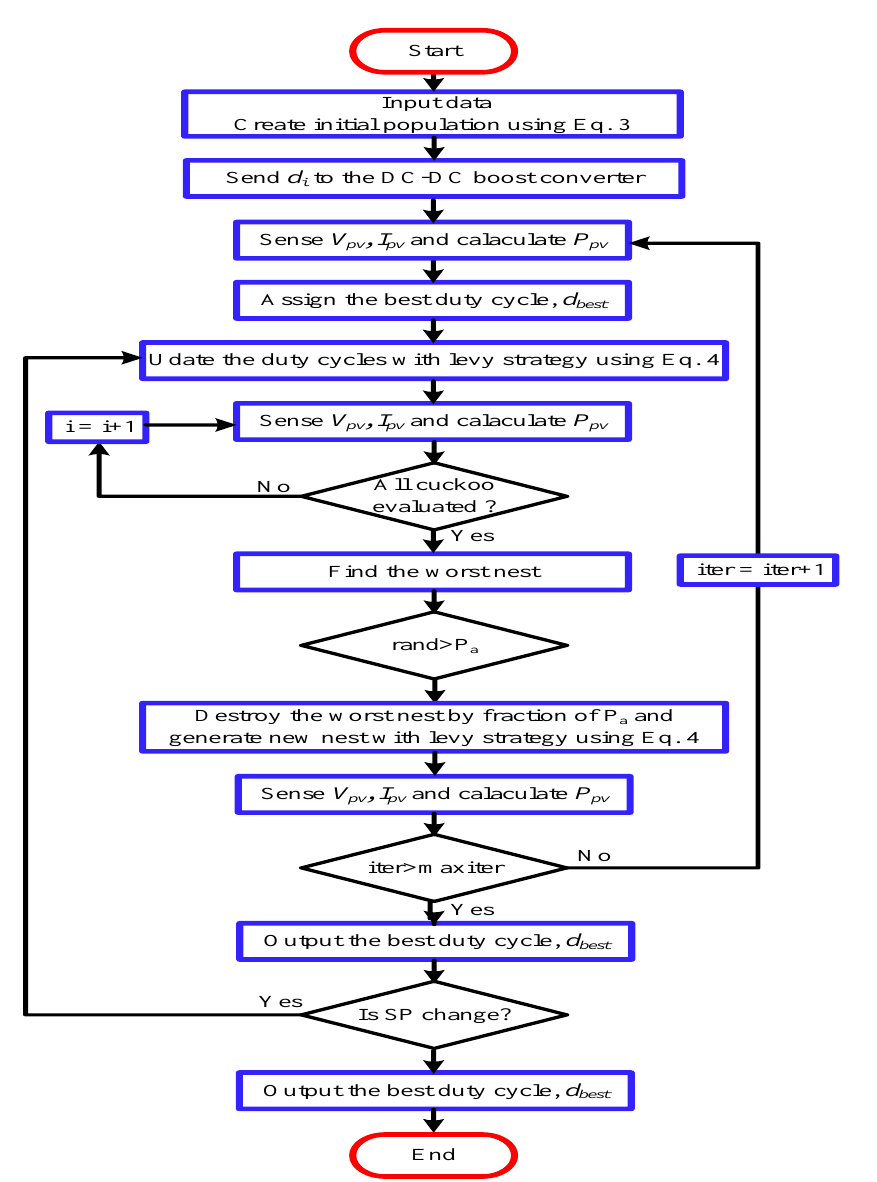
Figure 4. Flowchart of the CSO-based MPPT for PV system.